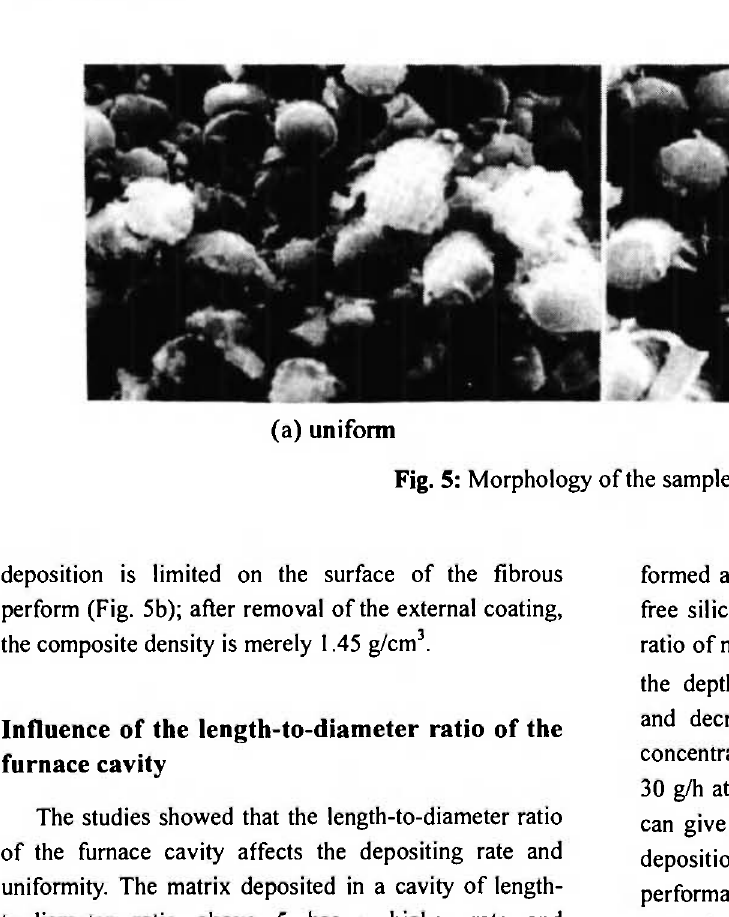
Fig. 5: Morphology of the sample